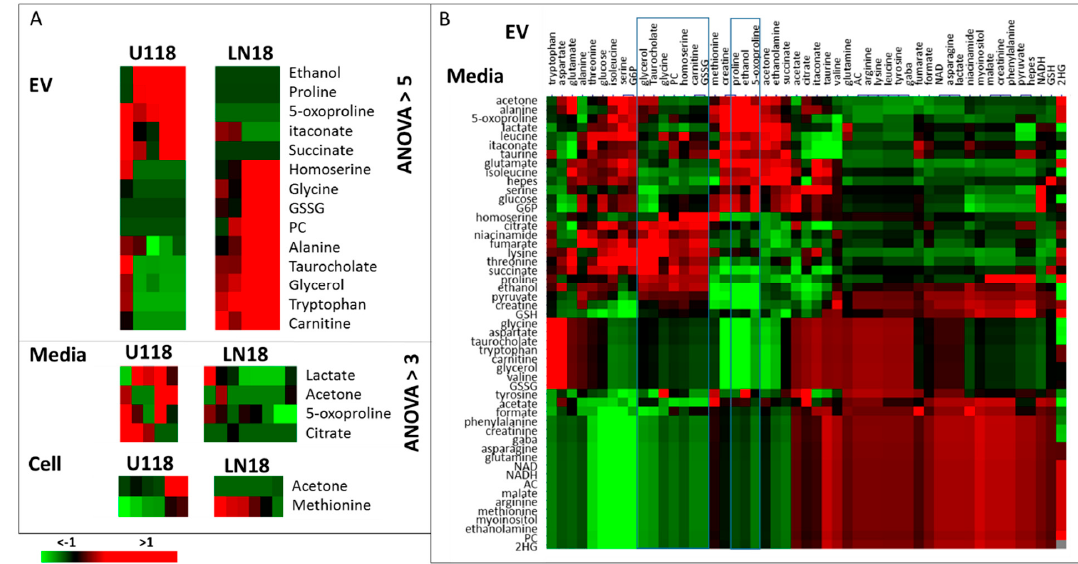
Figure 6. ( A ) ANOVA analysis of major metabolic differences between EVs, media and cells for LN18 and U118 lines. EVs show the biggest difference between two cell lines with the number of metabolites having an ANOVA value over 5. For cells and media, differences are much more subtle, with only a small number of metabolite showing an ANOVA value over 3. ( B ) The difference between correlation coefficients of metabolites in EV and media of U118 and LN18 cells, where a positive value (red) indicates a higher correlation in U118 cell lines and a negative value (green) shows a higher correlation in LN18 cells. Protein measurements for EV-derived from U118 and LN18 cell lines have been previously published and made available by Lane et al. [15] with an extensive analysis of differences between LN18 and U118 cell lines and their EVs. Metabolic pathways that include a significant number of metabolites found to have significantly different concentrations in LN18 and U118 EVs (Figure 6), and proteins found to be present in LN18 but not U118 [15], are presented in Figure 7. The determination of statistically significant pathway enrichment was done using Metaboanalyst [36]. A significant overlap in pathways enriched with metabolic products and enzymes suggests a possibility for the enzymatic and metabolic functionality of EVs in the media.